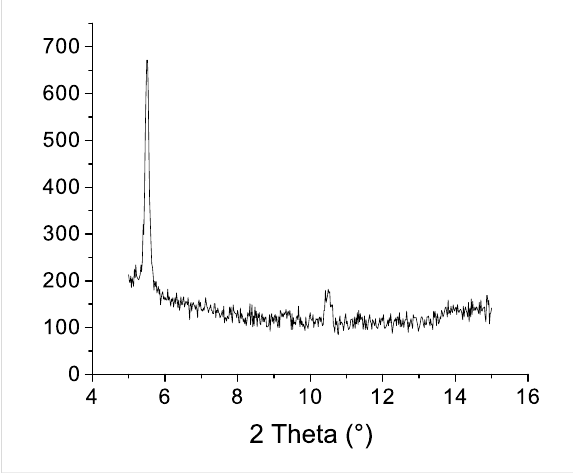
Figure 12: X-ray powder diffraction (XRPD) diagram of ( S,R )- 1a water/ DMSO xerogel.